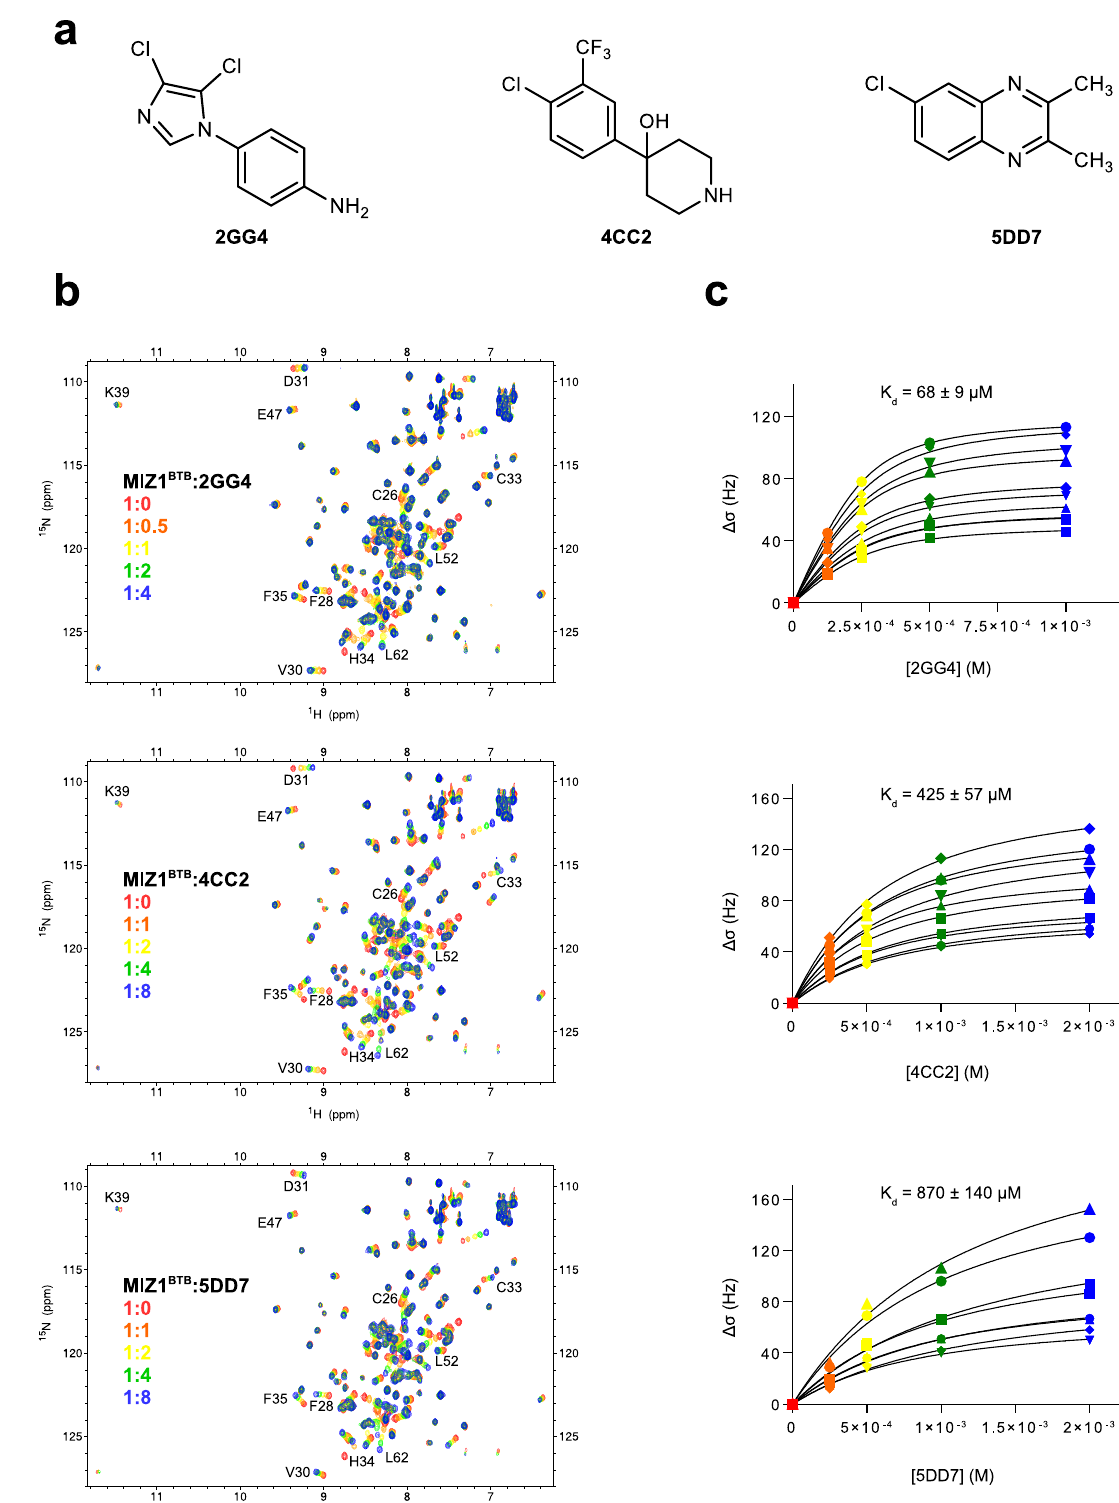
Fig. 1 | MIZ1 BTB bindsdifferent classesofsmallmoleculeligands.a The chemical structures of fragments that bind to MIZ1 BTB ; b The 1 H- 15 N HSQC spectra of MIZ1 BTB (red)titratedwiththethreefragments.ThemolarratiosofMIZ1 BTB -ligandsarelisted and colors correspond to coloring of the spectra. Selected residues experiencing